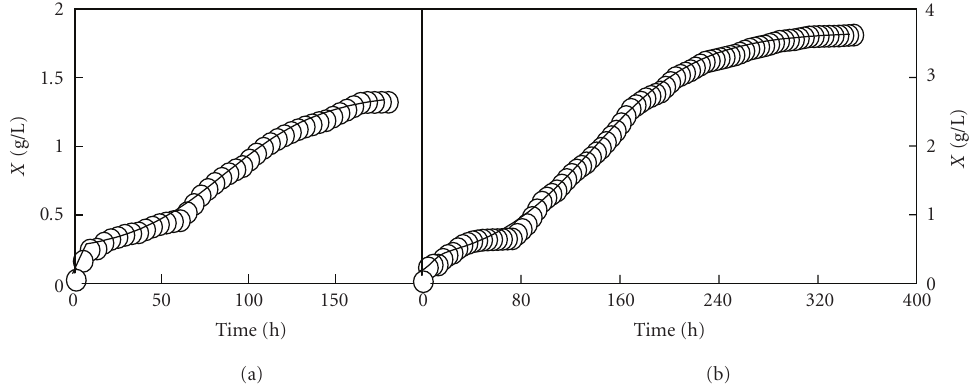
Figure 7: Growth curves of Ent. faecium CECT 410 corresponding to the realkalized fed-batch fermentations I (a) and II (b). The growth data (symbols) represented in the left (a) and right (b) parts are, respectively, the experimental biomass data showed in Figures 3 and 4. The solid lines drawn through the experimental biomass data were obtained according to the bi-Logistic model